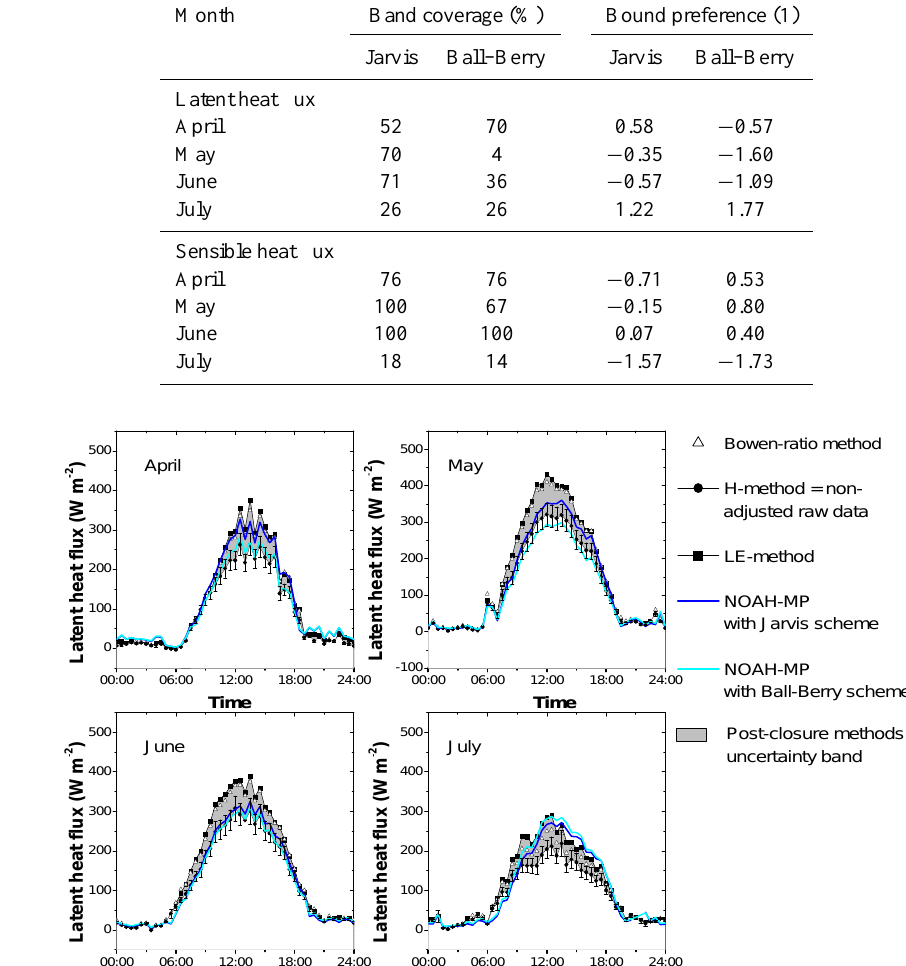
Figure 9. Measured and simulated monthly average diurnal cycles of latent heat flux over a winter wheat stand in southwest Germany. For modelling, the NOAH-MP land surface model was used in two configurations. The stomatal resistance was computed either with the empirical Jarvis scheme or the photosynthesis-based Ball–Berry scheme. The grey band shows the post-closure methods uncertainty band (PUB) computed as the difference between sensible heat ( H )- and latent heat (LE)-adjusted fluxes. The error bars indicate the random measurement error. In some cases, the error bars are smaller than the size of the symbol and therefore not